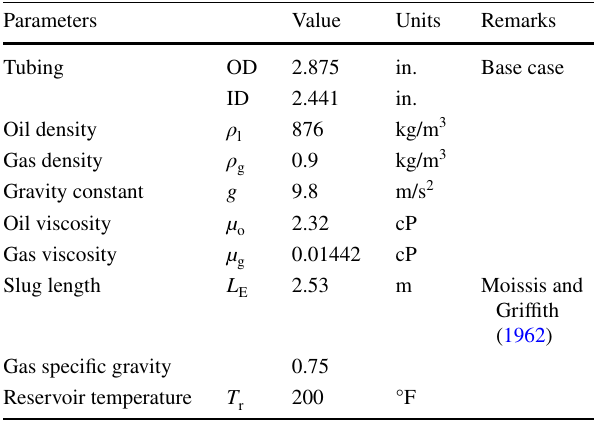
Table 1 Well T basic